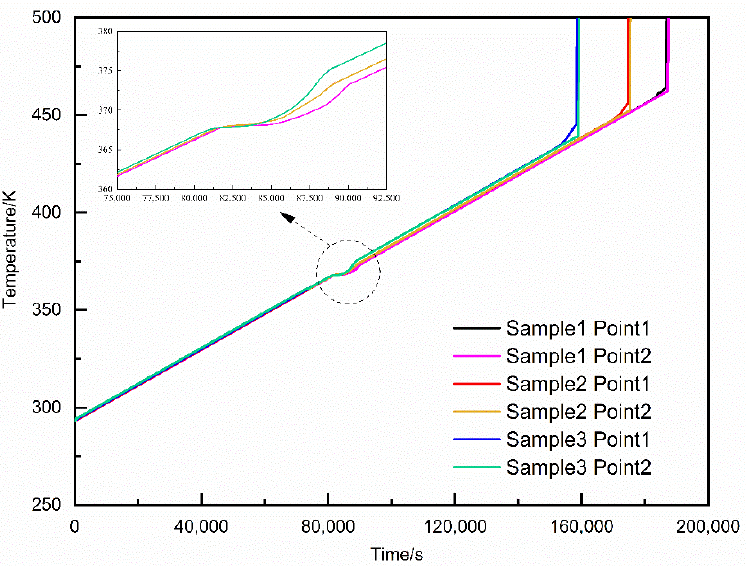
Figure 11. Temperature-time curve of spherical NQ/DNAN melt-cast explosive with different solid content.